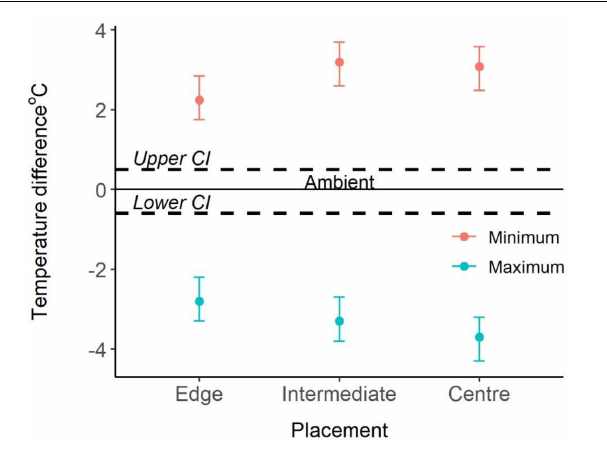
FIGURE 2 | Comparison of ambient and internal temperatures. 0 ◦ C and the solid line represent the ambient temperature, the dotted lines represent the confidence intervals, and the points represent the difference to ambient temperatures (mean ± 95%